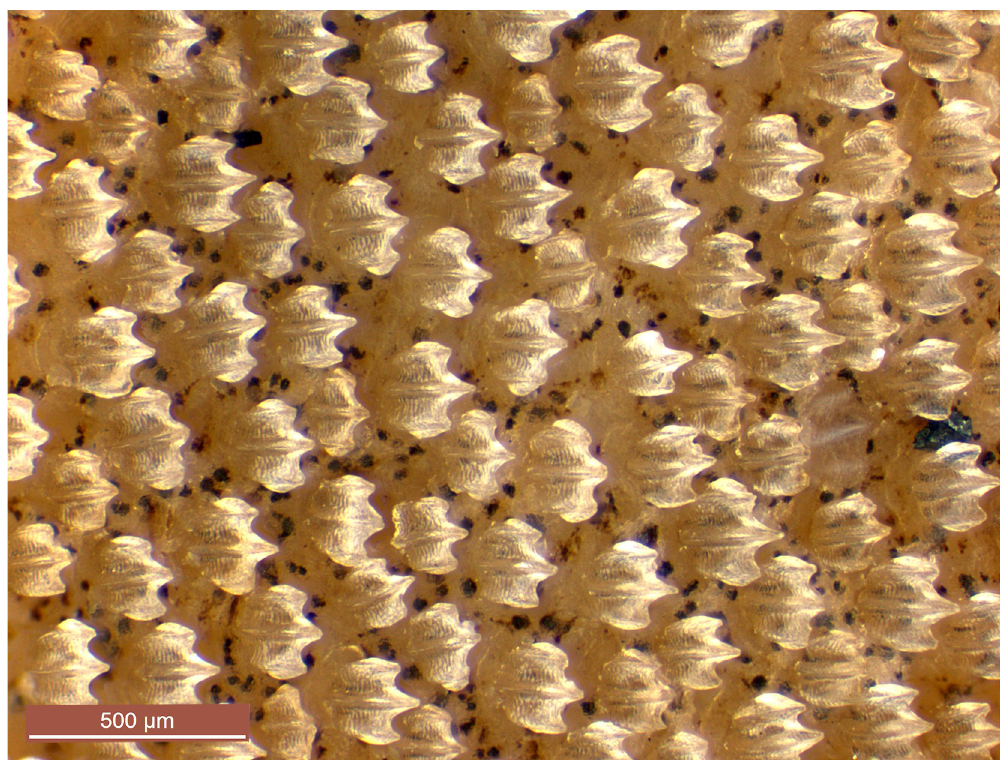
Fig 7. Lateral trunk denticles of Carcharhinus obsolerus sp. nov. (NMW 61463, holotype). 433 mm TL female.